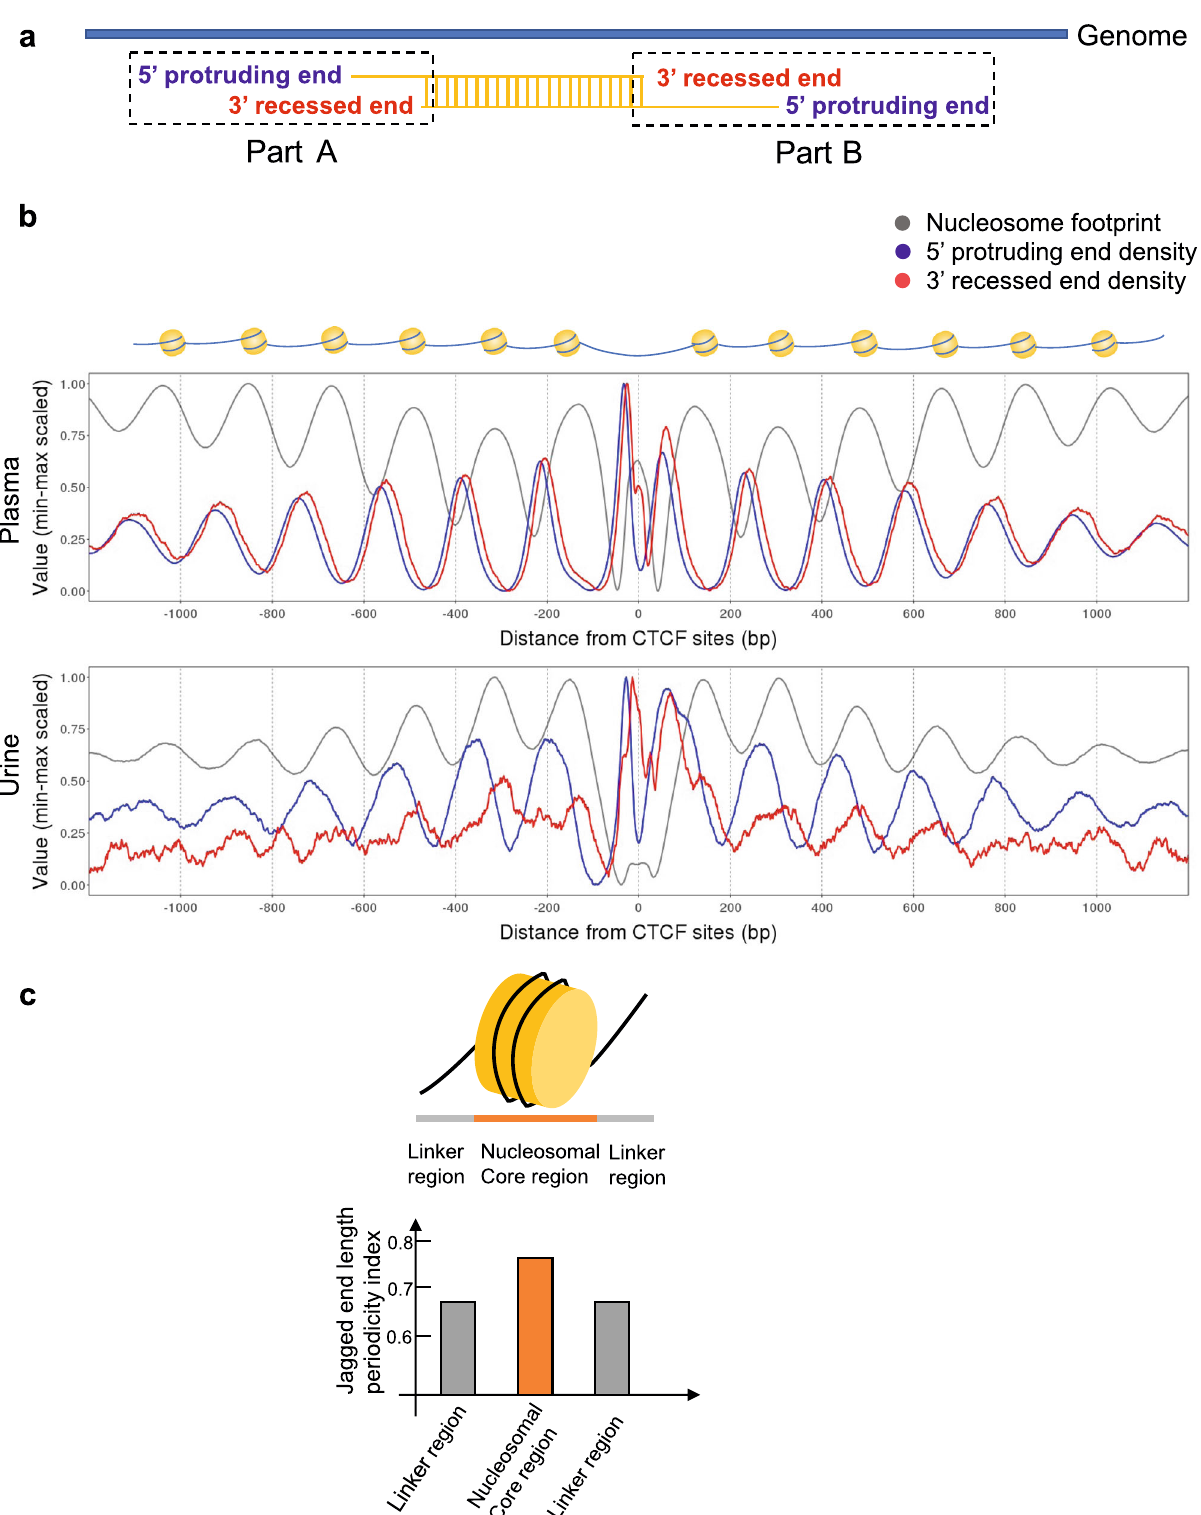
Fig. 6 Relationship between jagged ends and nucleosome tracks. a Illustration for the de fi nition of 5 ′ protruding end and 3 ′ recessed end in part A and part B. b 5 ′ protruding end density and 3 ′ recessed end density surrounding CTCF binding sites for plasma and urinary DNA molecules in part A. c Jagged end length periodicity index in nucleosomal linker regions and nucleosomal core